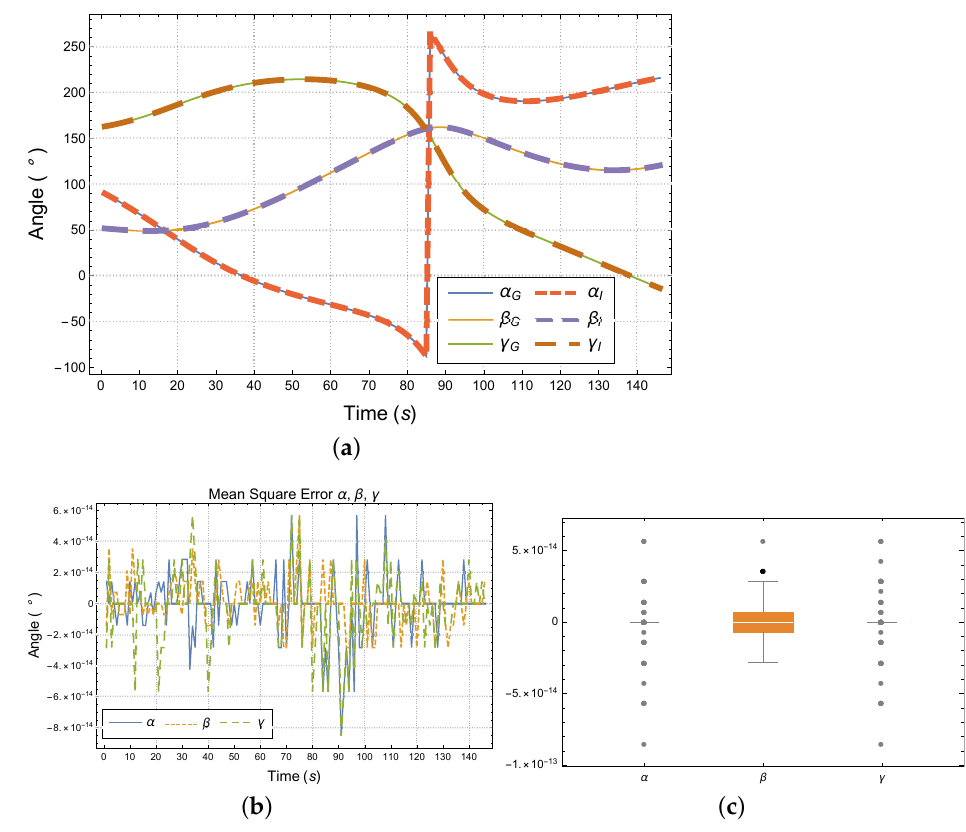
Figure 9. A comparison of the mathematical models of the orientation analysis. ( a ) Comparison of the orientation ( α , β , γ ) between CAD mechanical design and orientations equations. ( b ) Mean Square Error of the orientation. ( c ) Box plot of the orientation.